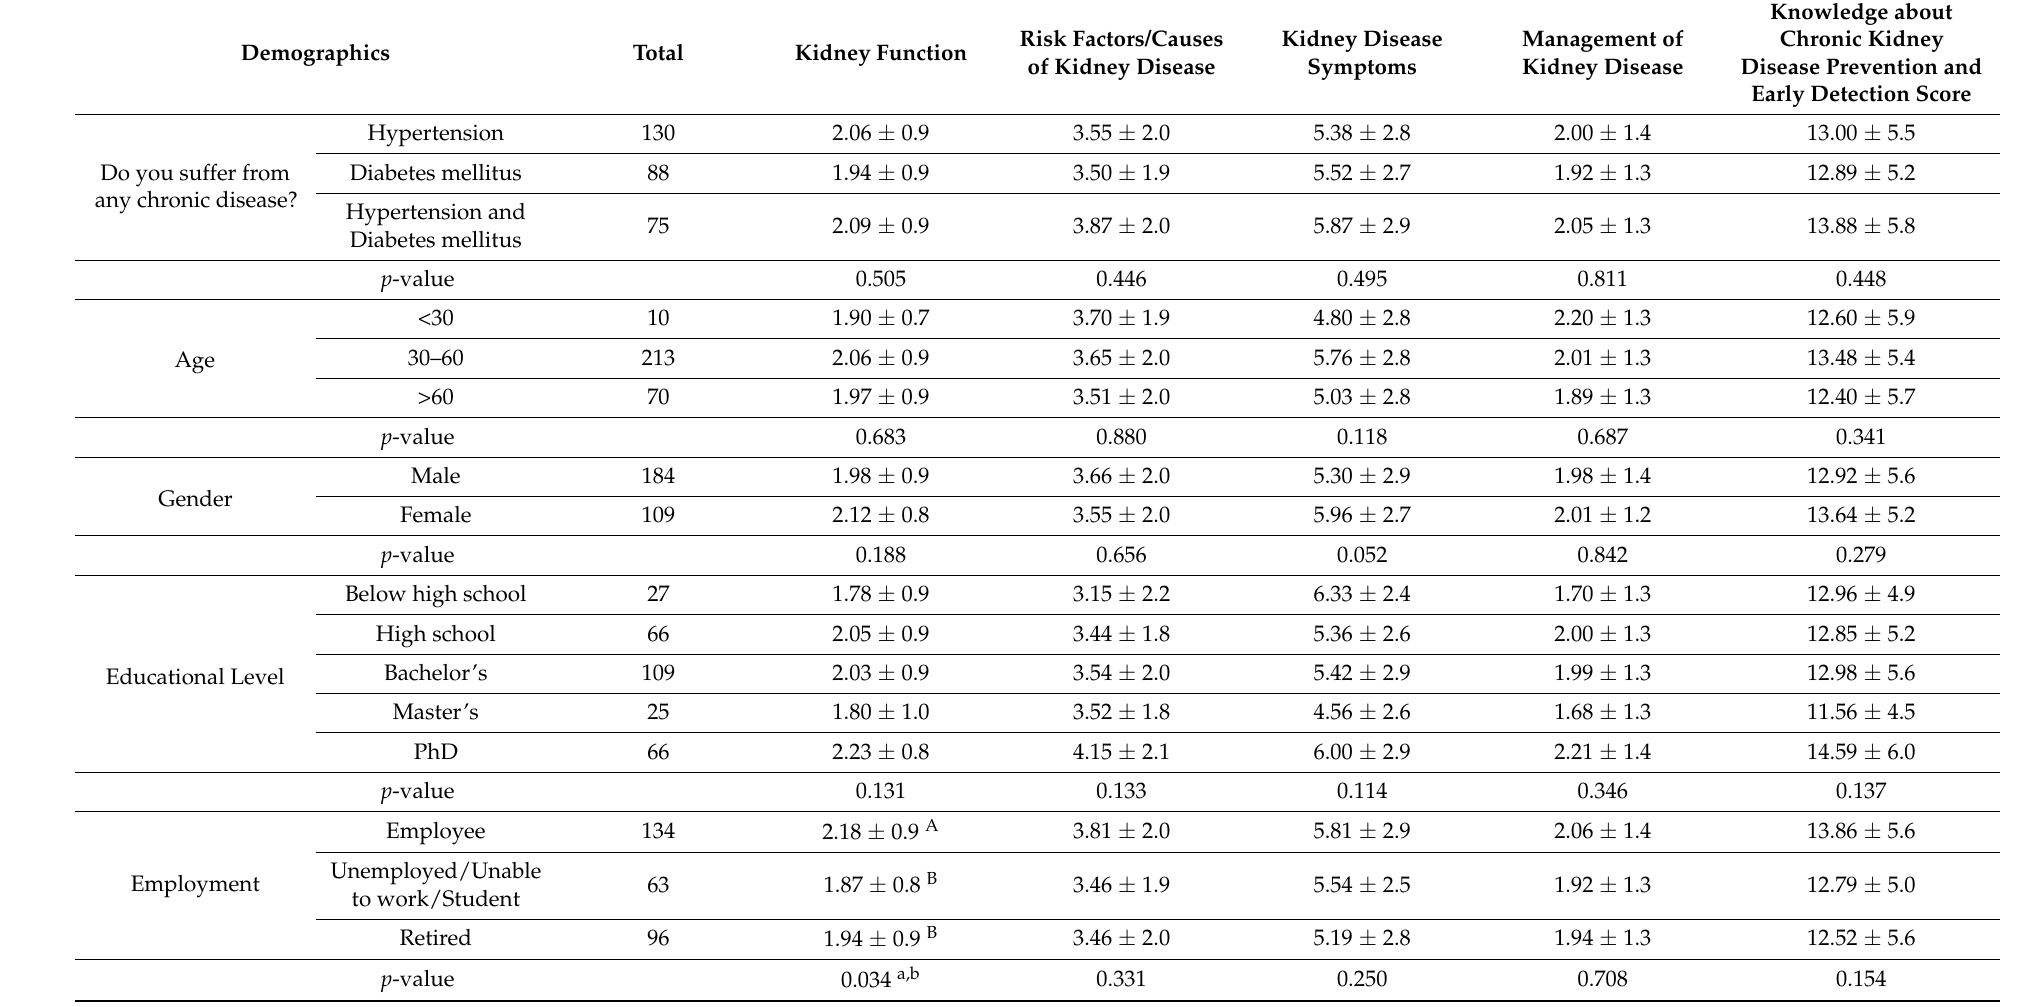
Table 2. Statistical analysis on participants’ knowledge about CKD prevention and early detection.